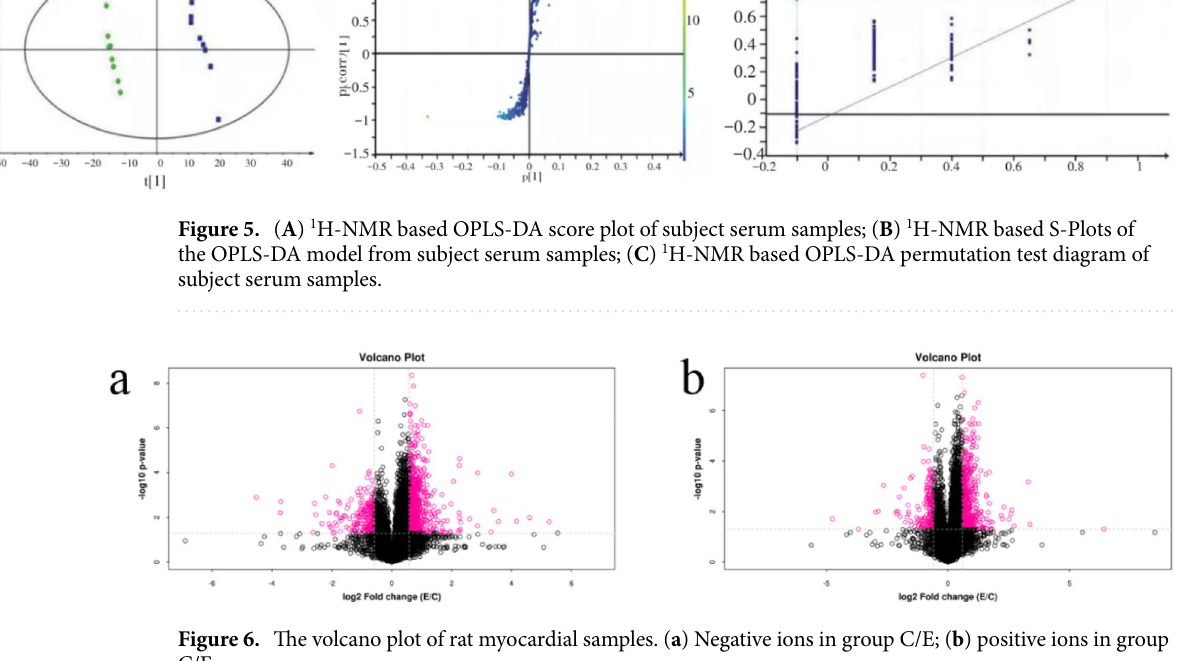
Figure 6. The volcano plot of rat myocardial samples. ( a ) Negative ions in group C/E; ( b ) positive ions in group